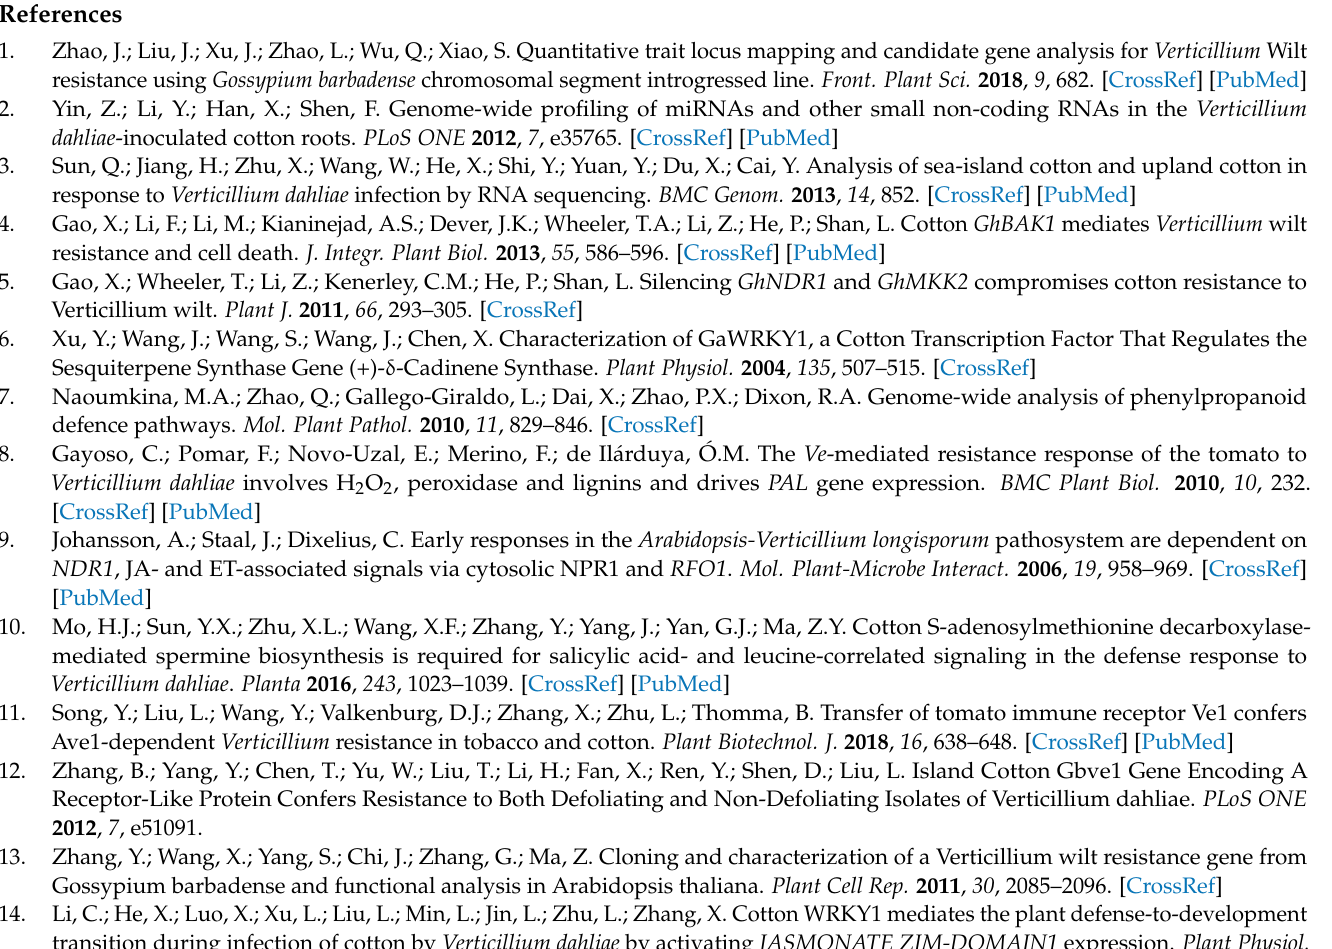
Figure S3: Comparison of phenotypes at different days after inoculation in VIGS